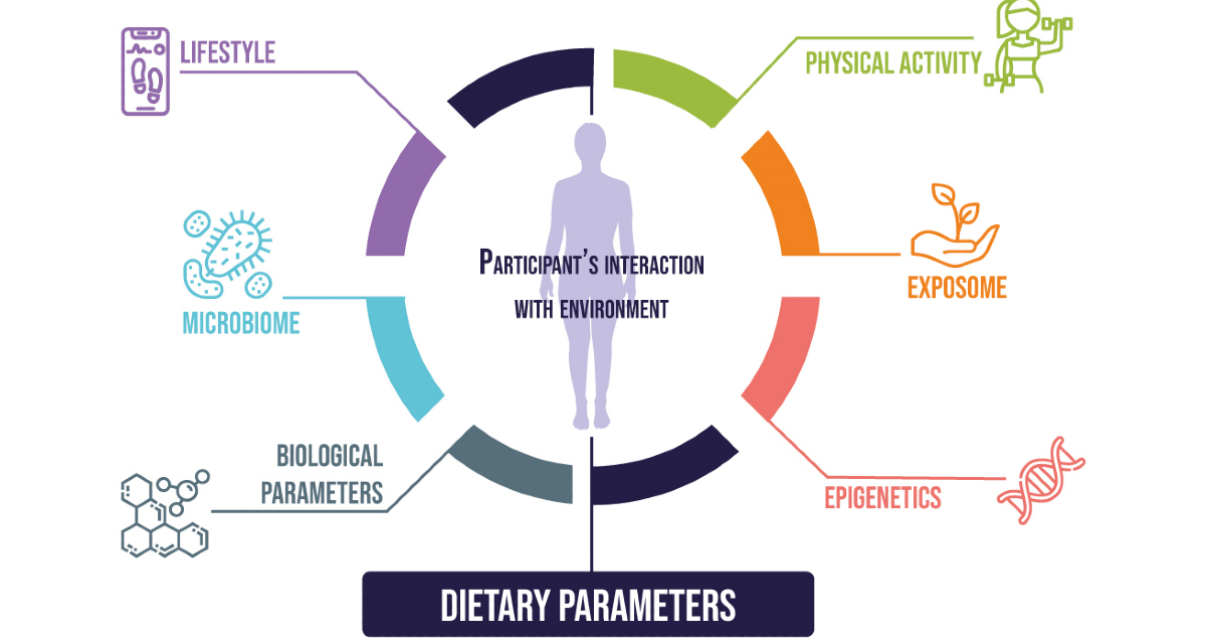
Figure 2. Parameters that can be measured or accounted for along with dietary parameters in medical